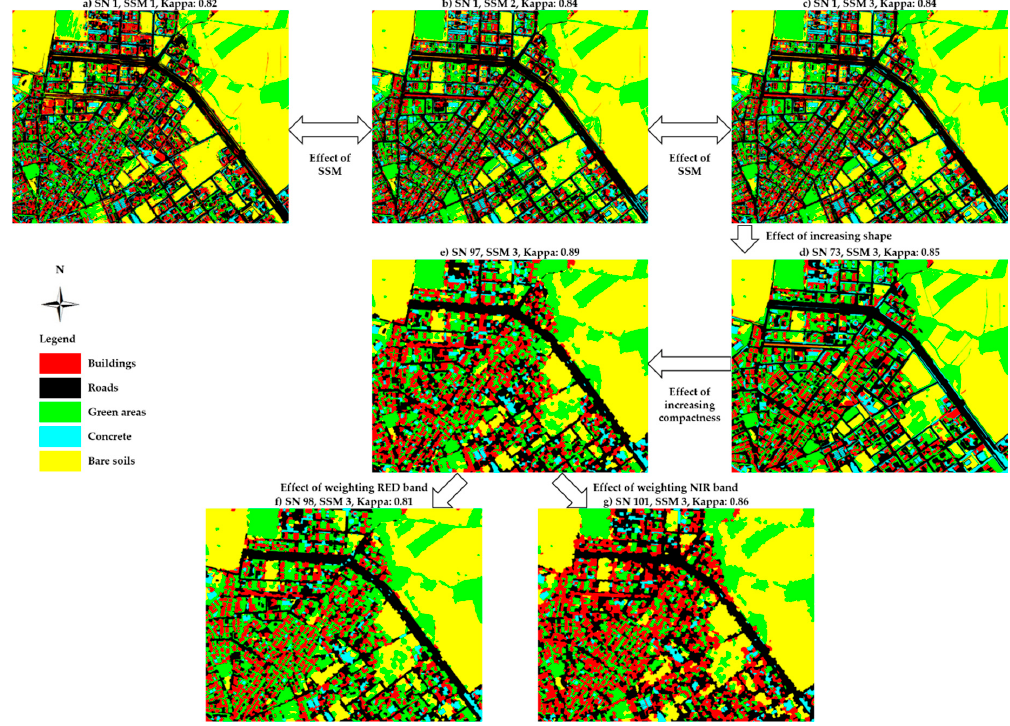
Figure 15. Classification examples.